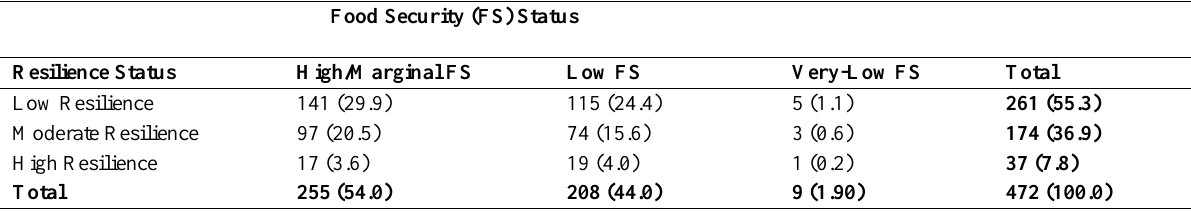
Table 3 : Resilience categories and Food security status of the